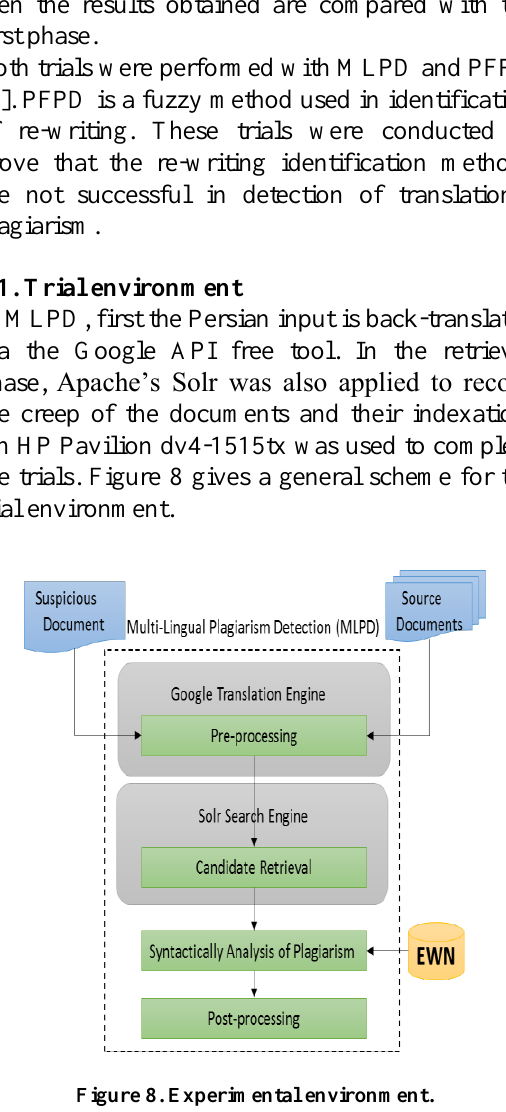
Figure 8. Experimental environment.